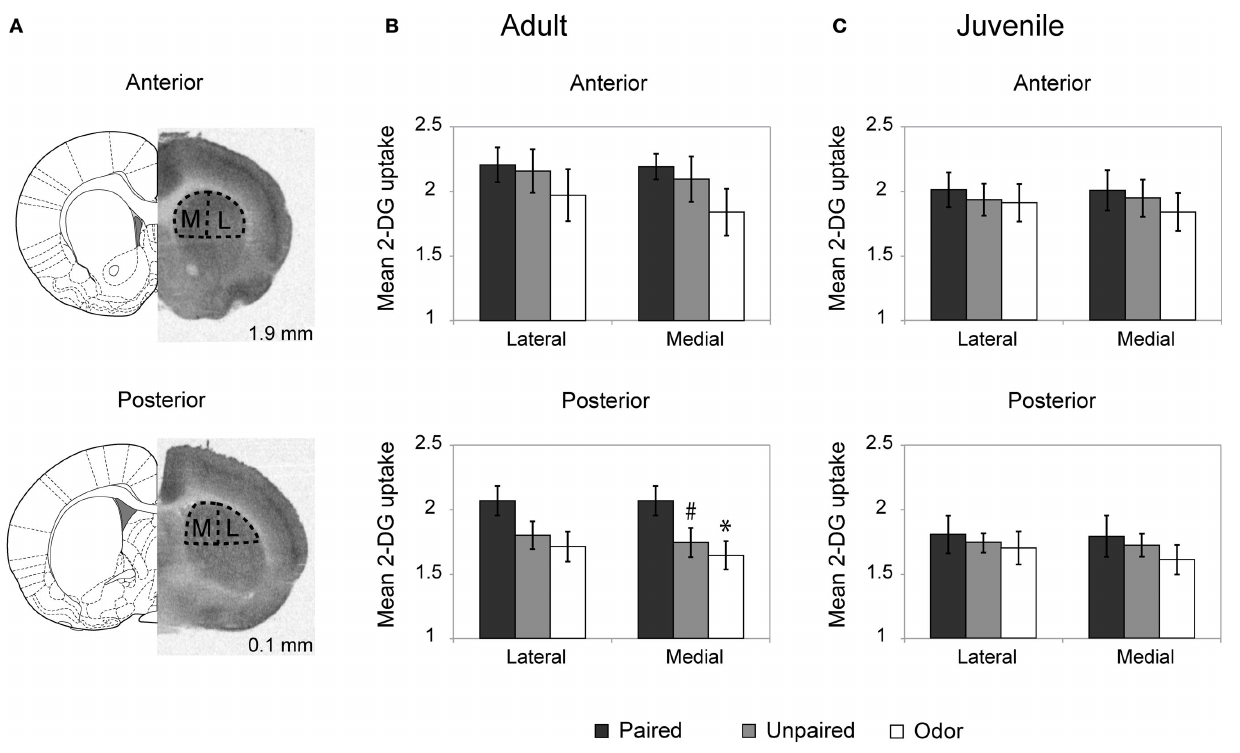
FIGURE 2 | Striatum 2-DG autoradiography during odor fear conditioning. (A) 2-DG autoradiograph with the corresponding coronal brain sections from Paxinos and Watson (1986; numbers on the right indicate distance relative to bregma in mm). Anterior and posterior parts of the dorsal striatum were analyzed separately and subdivided in lateral (L) and medial (M) portions for optical densitometric measurements.